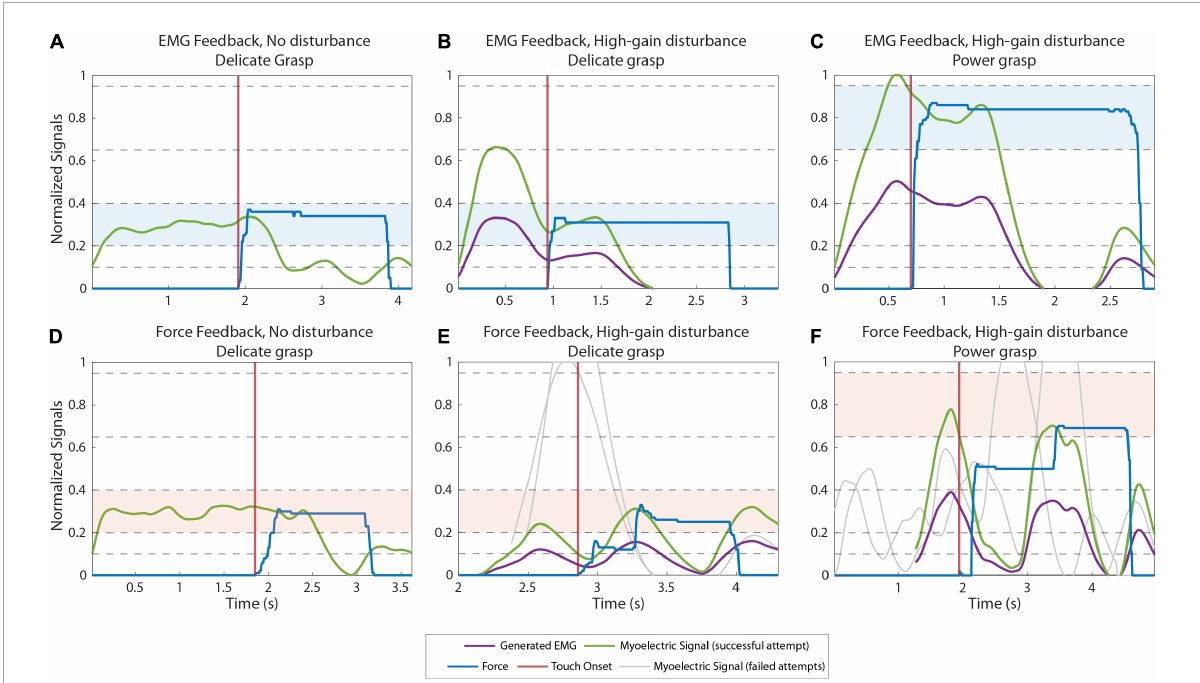
FIGURE4 Example myoelectric (ME) and force traces recorded during normal (A,D) and high-gain disturbed (B,C,E,F) trials when using EMG feedback (A–C) and force feedback (D–F) . The green and blue lines correspond to the ME signal and the force applied in the last (successful) attempt in a trial, respectively. The purple lines are the ME signals produced by the subjects before the signal is multiplied by the disturbance gain. The gray lines are the ME signals generated in previous attempts of the same trial. The ME signals of all attempts are aligned on their respective contact points (when the prosthesis contacts the object), denoted by the vertical red lines. The target levels in each trial are highlighted with blue (A–C) and red (D–F) colored